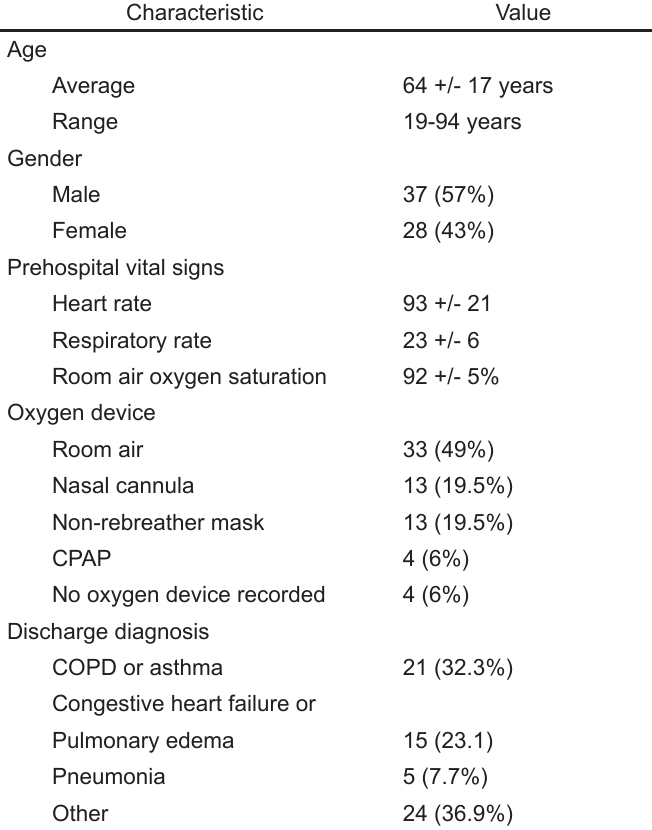
Table 1. Demographics and clinical characteristics of patients evaluated by paramedics using a portable device to